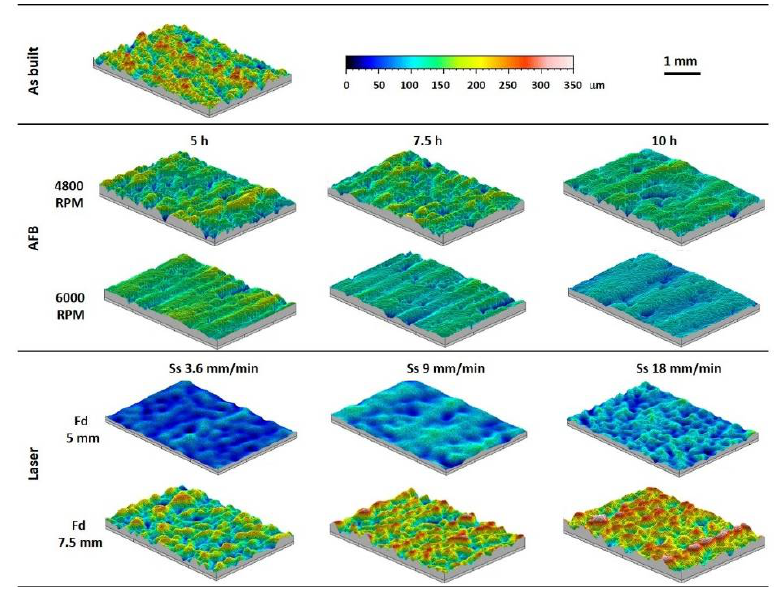
Figure 4. Three-dimensional maps acquired by the profiler on the as-built sample and treated ones.